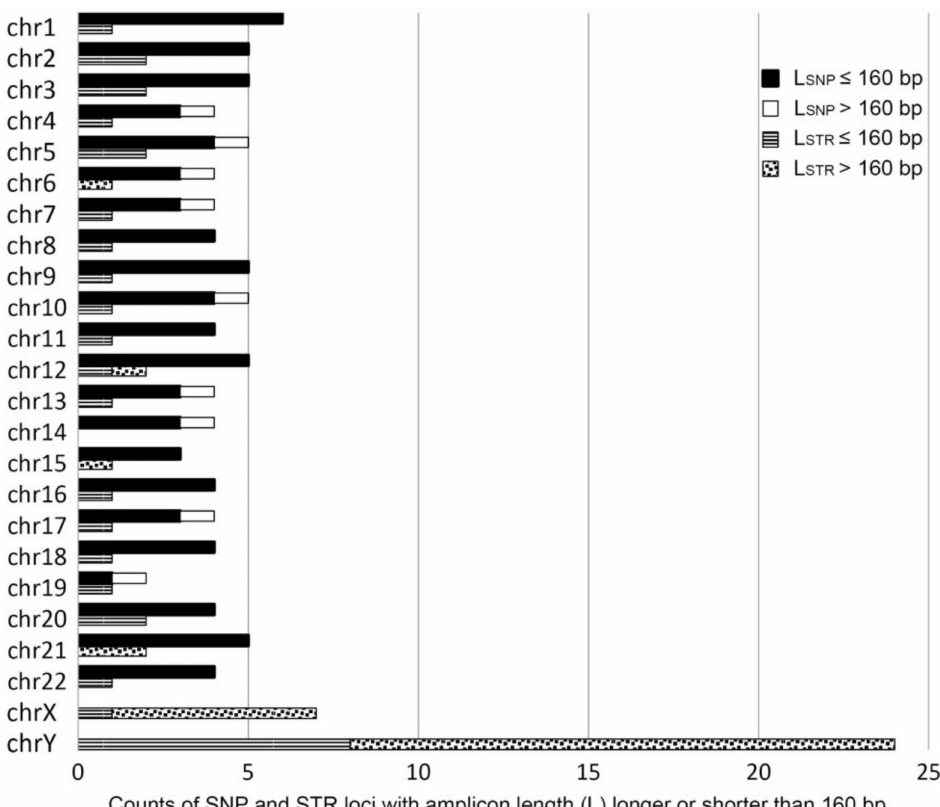
Figure 2. The density of single nucleotide polymorphisms (SNPs) and short tandem repeats (STRs) across different chromosomes and the number of SNP and STR loci with amplicon length (L) longer or shorter than 160